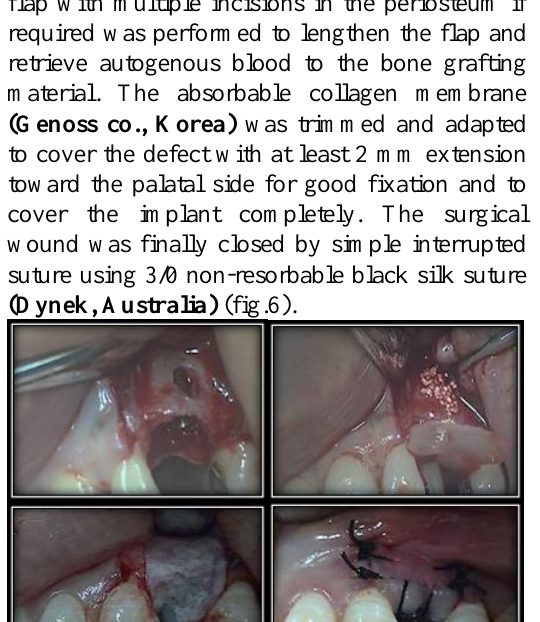
Figure 4: Drilling in: A-anterior mandible, B-anterior maxilla.